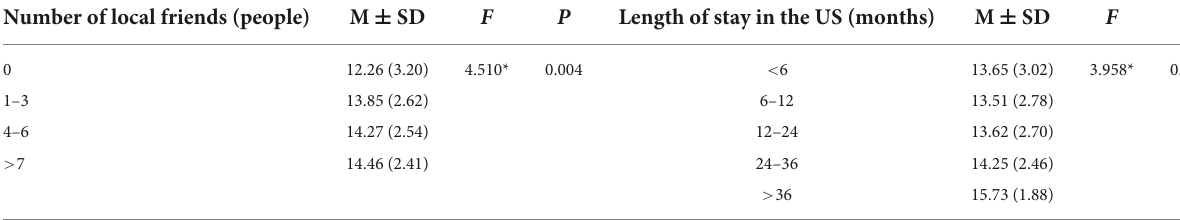
TABLE 5 A difference test of the number of local friends and the length of stay in the US on intercultural adaptation strategies. Number of local friends (people) M ± SD